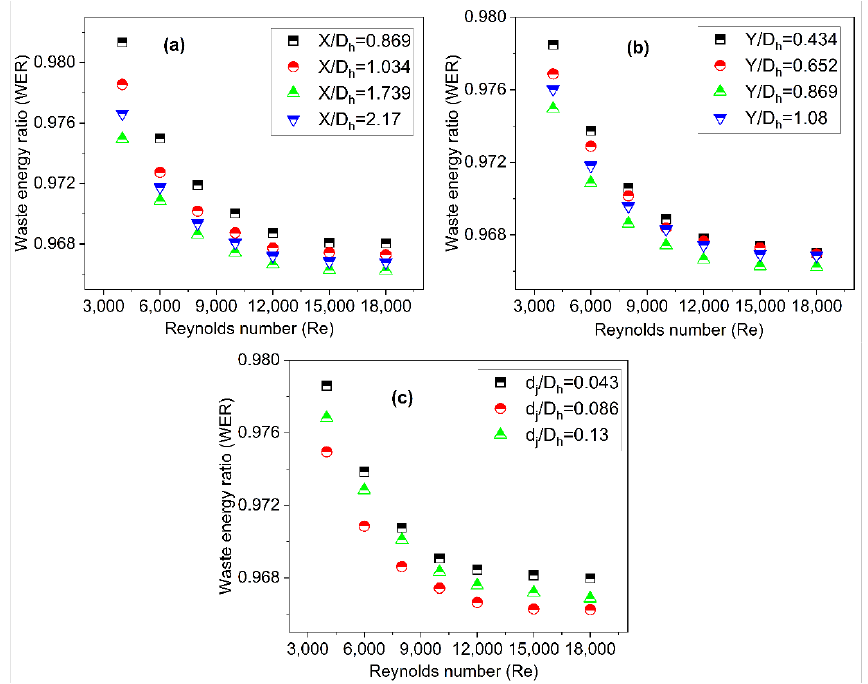
Figure 18. Waste heat recovery ( WER ) variation for ( a ) X/D h , ( b ) Y/D h and ( c ) d j /D h .